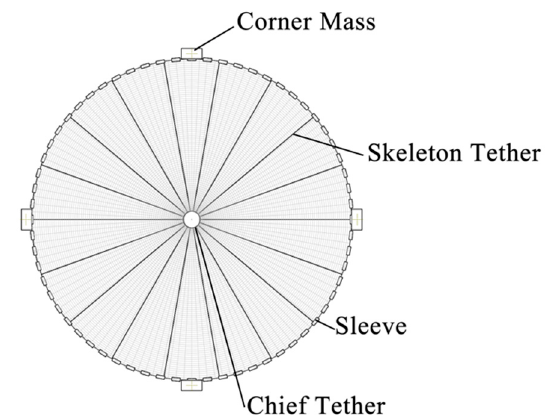
Figure 5. The configuration of the net.